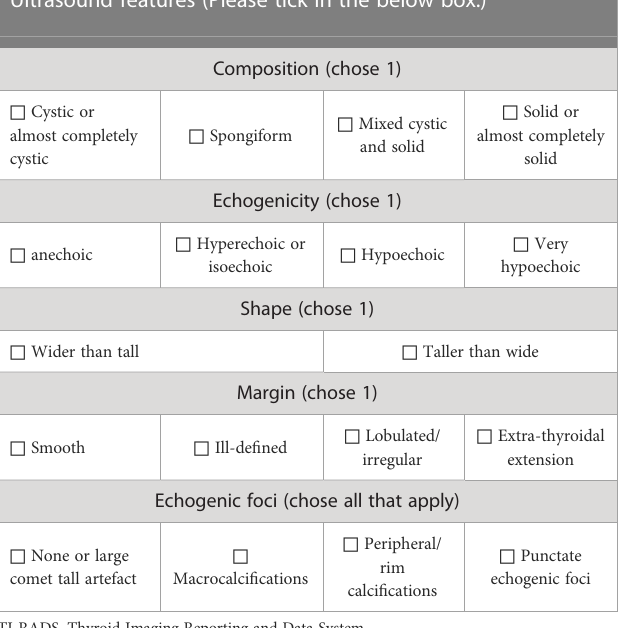
TABLE 3 Summary list of ultrasound features for TI-RADS classi fi cations. Ultrasound features (Please tick in the below box.)